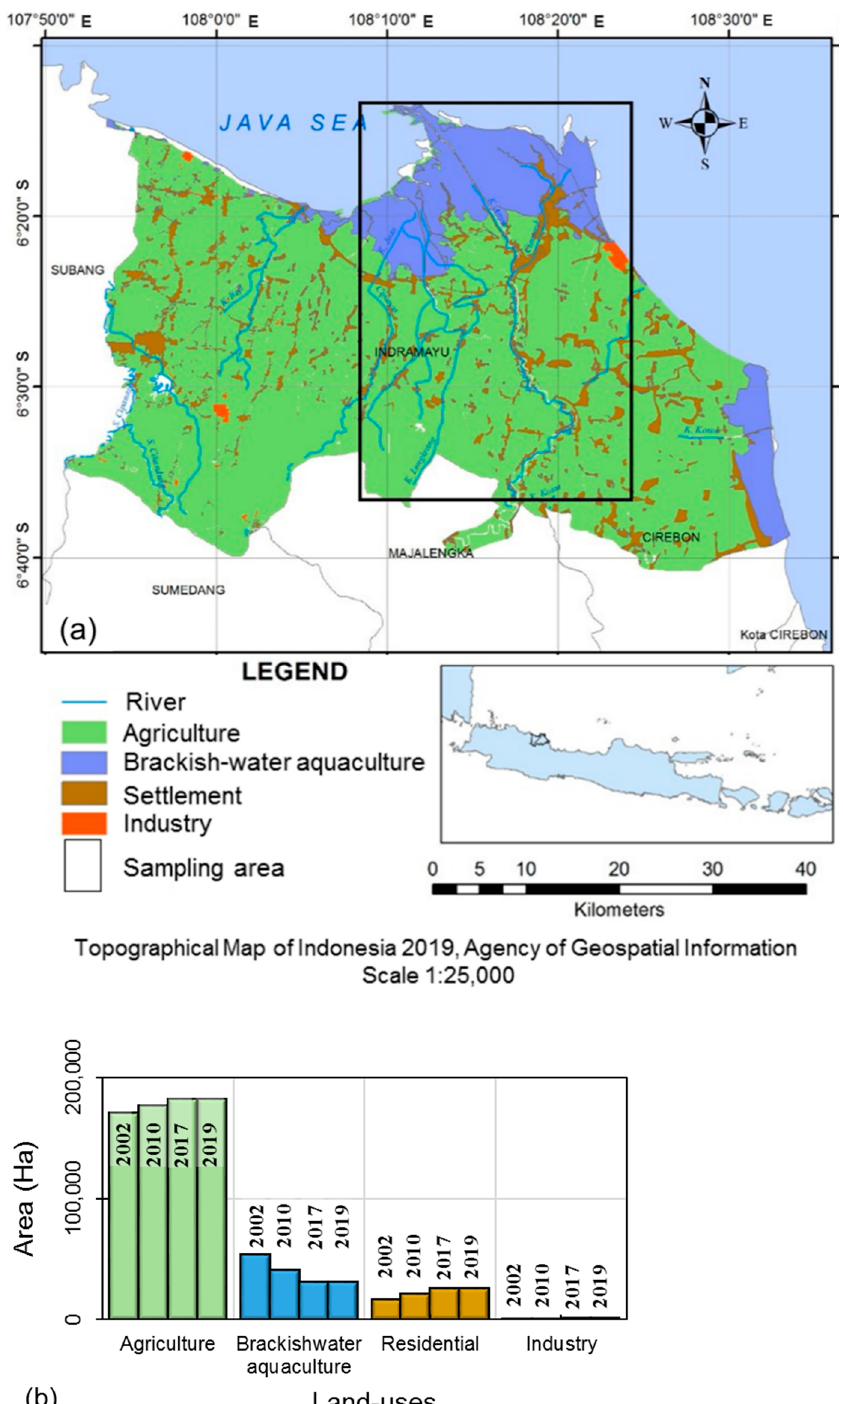
Figure 1. Land-use categories ( a ) and land-uses change from 2002 to 2019 ( b ) in Indramayu, Indo- nesia.